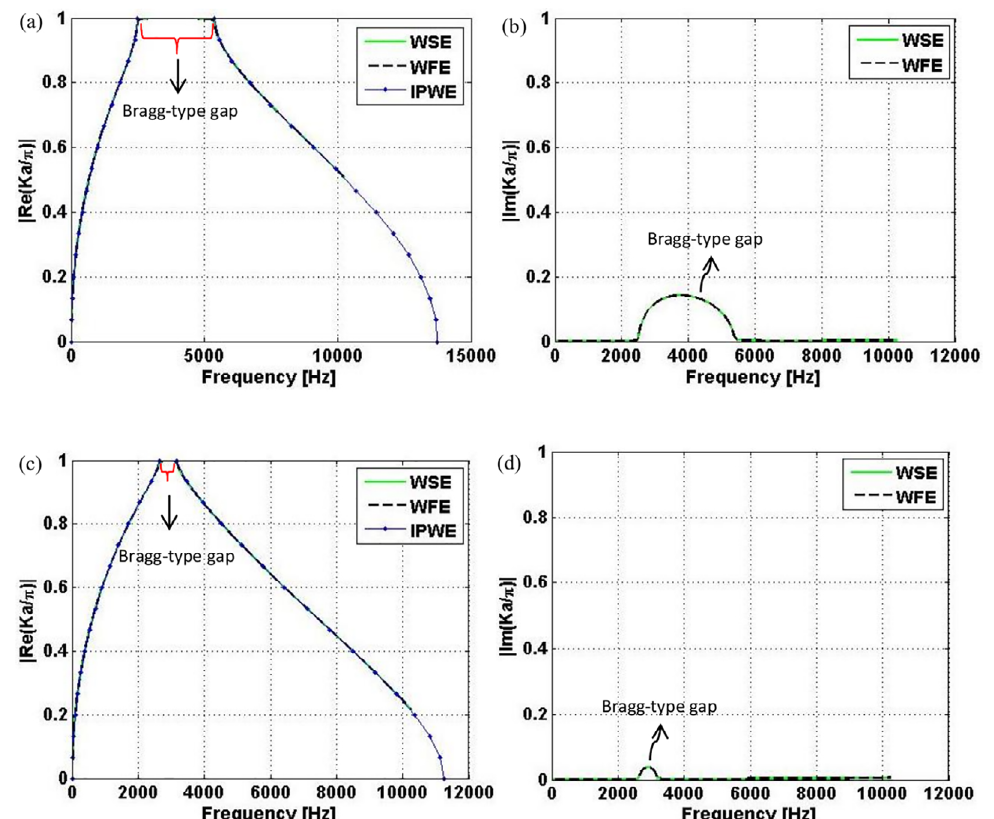
Figure 6. Complex elastic band structure of the PC beam considering N = 10 for models 1 (a-b) and 2 (c-d). The real part of the reduced Bloch wave vector (dimensionless) (a-c) is calculated by WSE, WFE and IPWE methods and the imaginary part of the reduced Bloch wave vector is calculated by WSE and WFE methods. real part of the reduced Bloch wave vector (dimensionless), Figure 7 (a-b) shows the comparison between the IPWE ka/π , using WSE, WFE and IPWE methods and Figure 6 and CPWE methods inside the FBZ 59 , i.e. [ -π/a, π/a ], for (b-d) shows the imaginary part of the reduced Bloch wave models 1 and 2, respectively. In Figure 7, only the first 10 vector using WSE and WFE methods. branches are illustrated. The matching between IPWE and CPWE does not occur only for the higher branches, even considering a high number of planes waves. In order to demonstrate the matching between WSE and IPWE methods for other values of N , we plot in Figure 8 (a) and (c) the real part of reduced Bloch wave vector for N = 2, 4, 6, 8, 10. It can be observed a good matching between WSE and IPWE methods. In Figure 8 (b) and (d), it is presented the imaginary part of reduced Bloch wave vector for N = 2, 4, 6, 8, 10 and its behaviour is similar to the discussed in Figure 5 (a-b), however, we also have the information of the unit cell attenuation performance and not only the band gap width. In Figure 8 (b-d), the best attenuation performance for N = 4, 6, 8, 10 is found for model 1, because more broad band gaps with higher attenuation are created. However, for N = 2, the best attenuation performance between models 1 and 2 is not clear, because both models present many band gaps with high